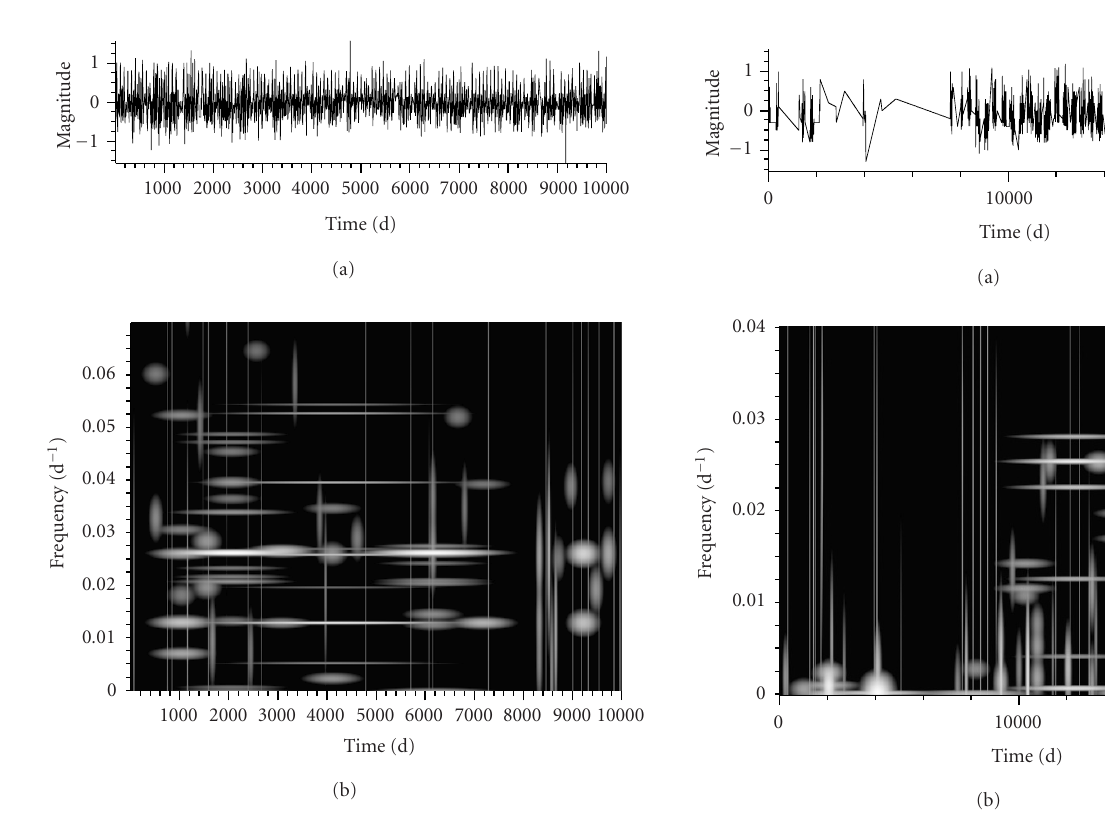
Figure 16: Time-frequency decomposition (b) of the RV Tauri sig- nal